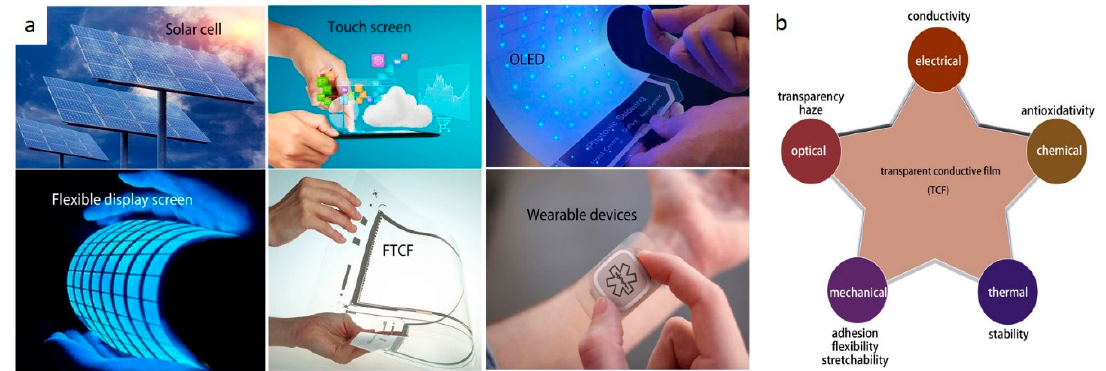
Figure 1. ( a ) Applications of AgNWs-based flexible transparent conductive film (FTCF). Reprinted with permission from [19]; Copyright 2018 Wiley-VCH Verlag GmbH & Co. KGaA. ( b ) Requirements of essential performance of FTCF [20].